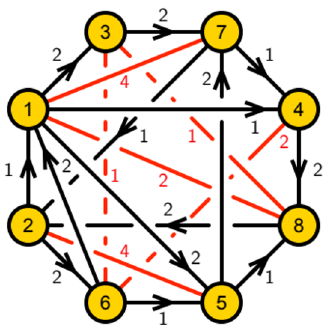
Figure 26 . Quiver for Model